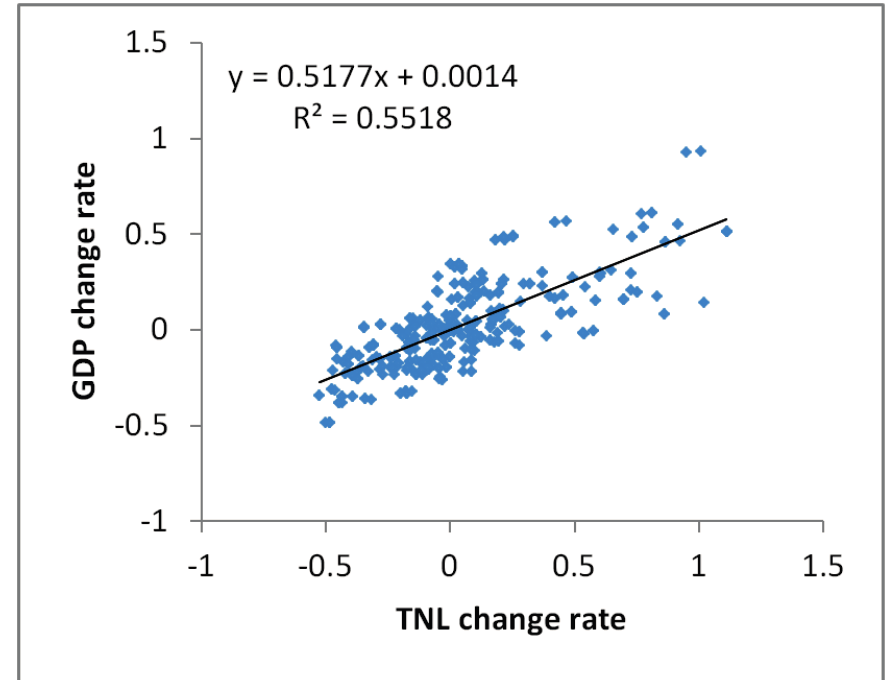
Figure 4. The scatter diagram showing the relationship between change rate of total nighttime light change rate and change rate of gross domestic product in Zimbabwe (Source: Li et al.